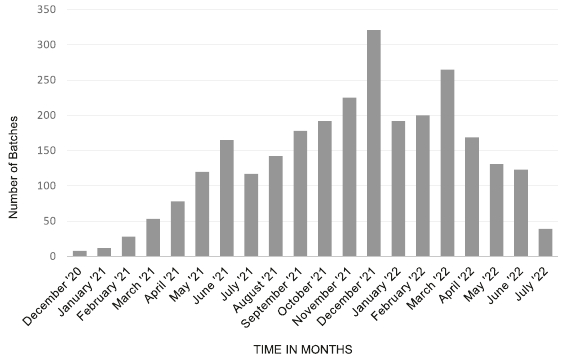
Fig. 3 Overview of the number of COVID-19 vaccines batches released by EU OMCLs from December 2020 to July 2022. All authorised vaccine types combined. X-axis represents months from December 2020 to July 2022, Y-axis is the number of vaccine